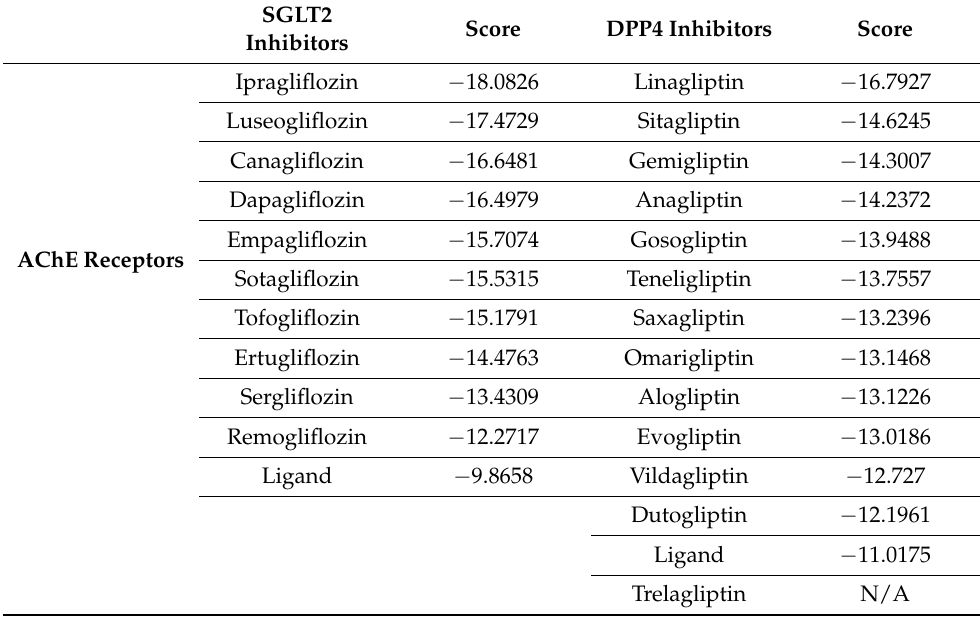
Table 1. Docking energy scores of 13 gliptins and 11 gliflozins with A2AAD and AChE